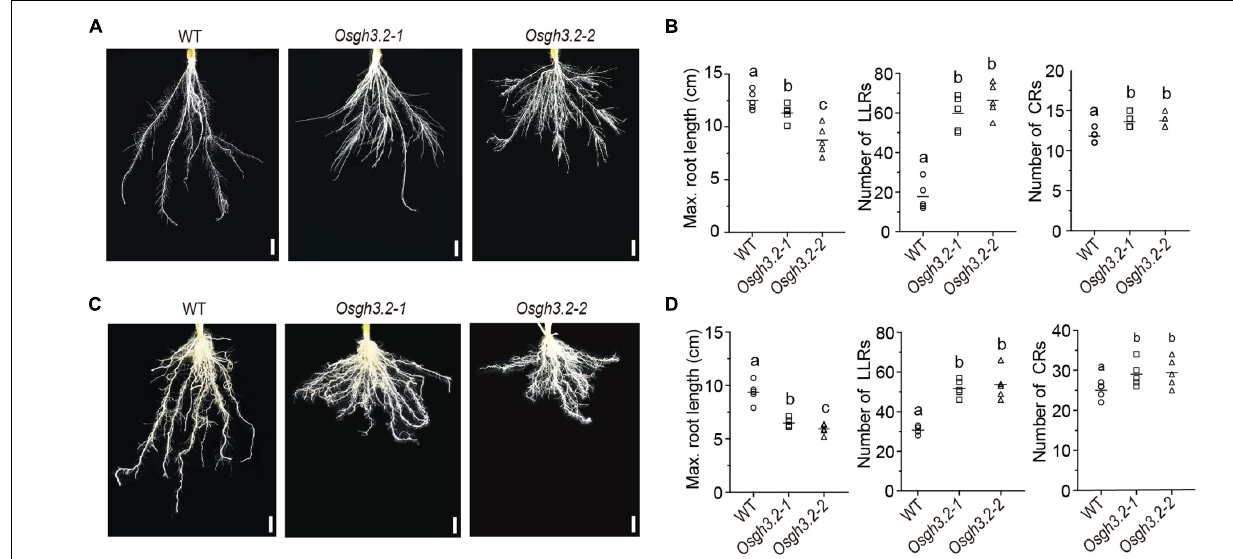
FIGURE 3 | Osgh3.2 mutants showed an altered “shallow” root architecture. Rice roots of wild-type, Osgh3.2-1 and Osgh3.2-2 after hydroponic culture (A) or inoculation by R. irregularis (C) for 3 weeks. Scale bars, 1 cm. (B,D) Maximum length of crown roots (CRs), number of large lateral roots (LLRs) and number of CRs were compared between wild type rice and the Osgh3.2 mutants under two cultivation conditions, respectively. Data are individual values from five biological replicates and the horizontal line shows the mean value. Statistical analysis was performed with Student’s t -test. Different letters indicate statistically significant differences ( P < 0.05).